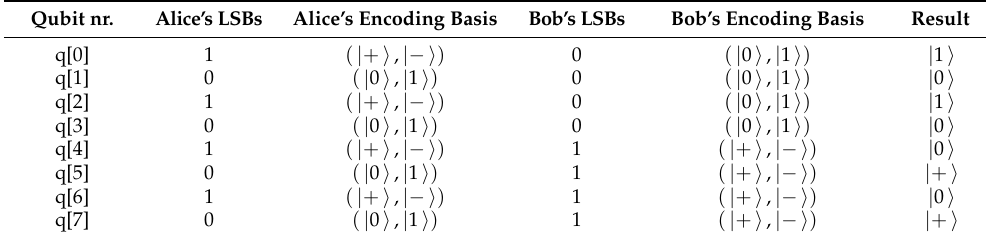
Figure 11. ( a ) The NEQR representation for the eighth pixel (gray level 76, LSB set to 0) and ( b ) the measurement results. Table 2. The selected basis for the LSB by Alice and Bob, their measurement basis, and the expected